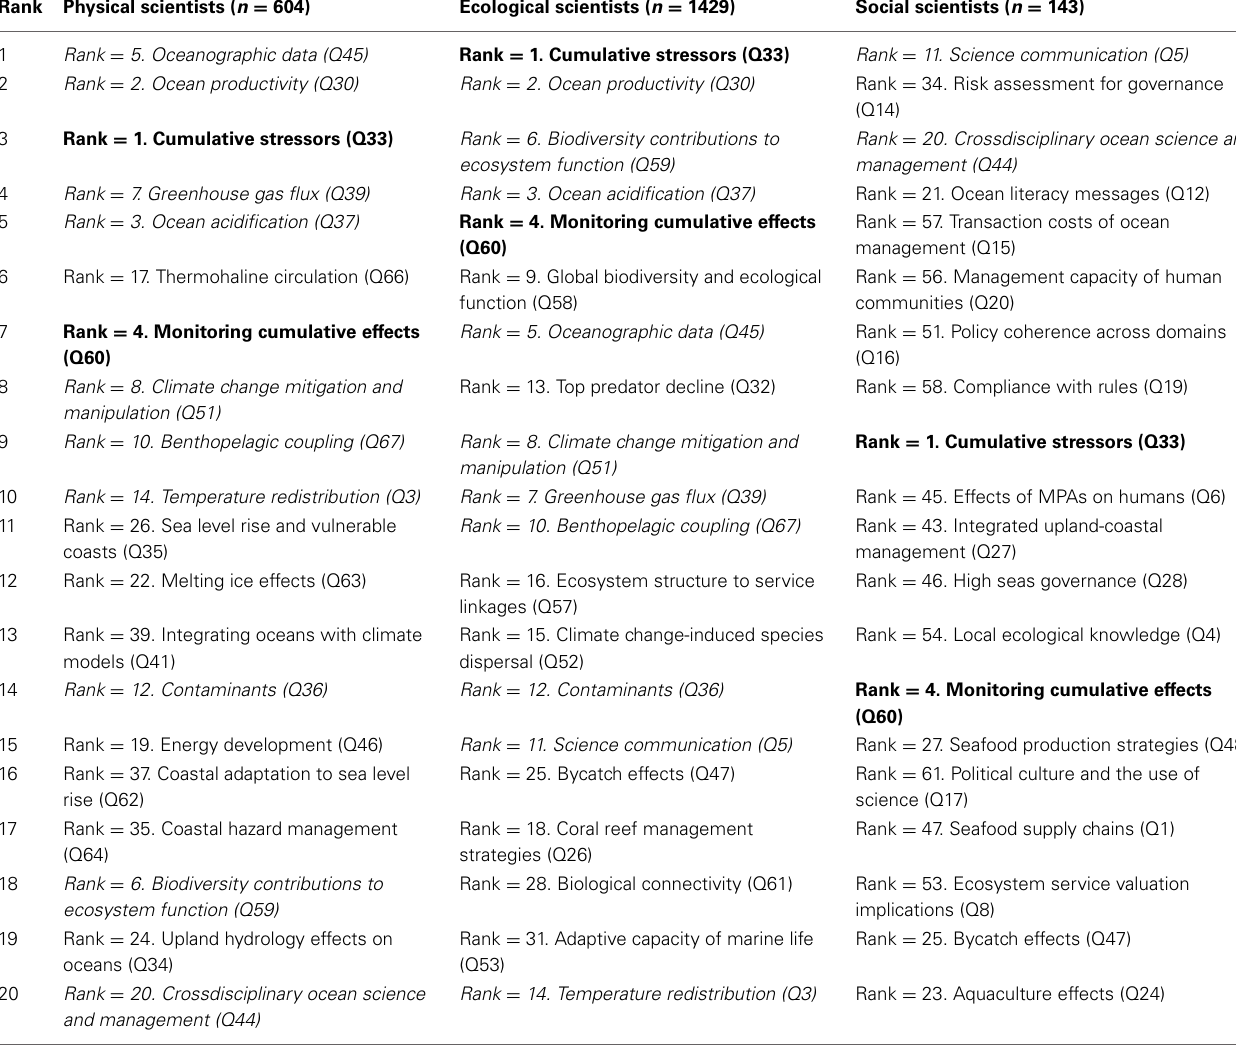
Table 6 | Comparison of 20 top ranked questions by disciplinary category. Rank Physical scientists ( n = 604) Ecological scientists ( n =